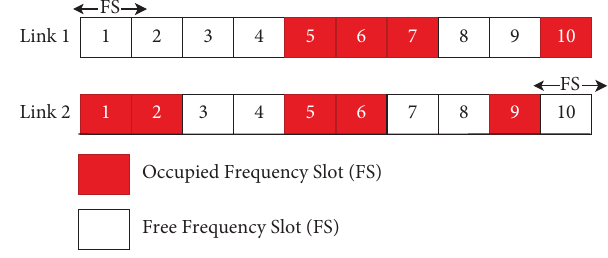
Figure 2: Spectrum fragmentation in the